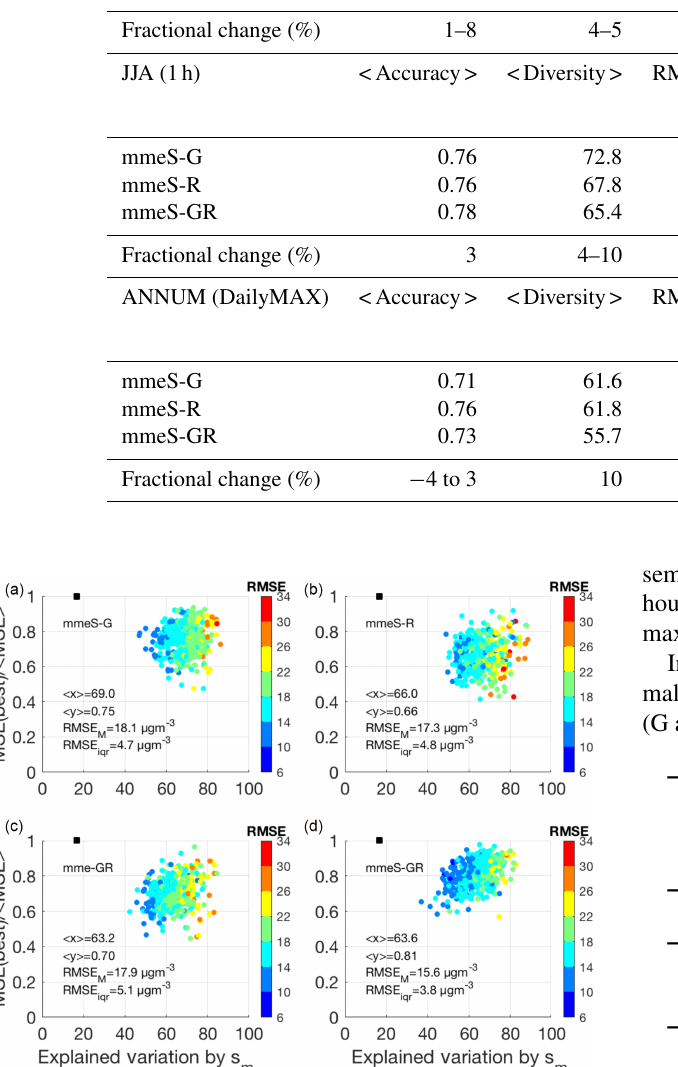
Figure 11. Representation of the accuracy ( y axis) vs. diversity ( x axis) and RMSE for the ensemble of the six most contributing global (a) and regional models (b) , and a hybrid ensemble calcu- lated with mme and mmeS ensemble methods (c, d) . For reference, the square represents the ideal point corresponding to an indepen- dent and identically distributed models (i.i.d ensemble). If the mod- els are i.i.d., then all eigenvalues are equal, each explains 1 /N of the variance and therefore for six models the point is at (0.16; 1). RMSE M is the median root mean square error, while RMSE iqr is the interquartile